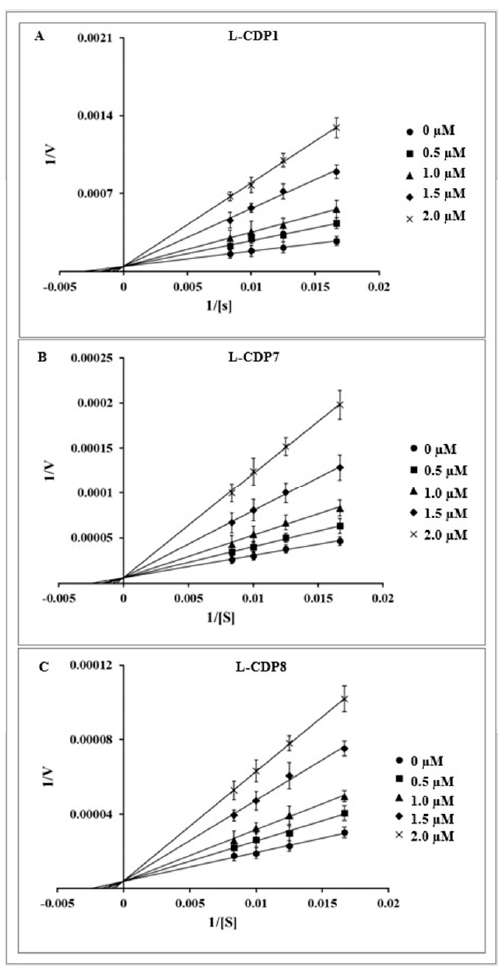
Figure 3. Inhibition mode of L-CDP1, L-CDP7, and L-CDP8 over SARS-CoV-2 3CL pro . Lineweaver- Burk plots to determine the inhibition modes are presented. [S] is the substrate concentration; v is the initial reaction rate. ( A ): Lineweaver-Burk plot for L-CDP1 inhibition of SARS-CoV-2 3CL pro . ( B ): Lineweaver-Burk plot for L-CDP7 inhibition of SARS-CoV-2 3CL pro . ( C ): Lineweaver-Burk plot for L-CDP8 inhibition of SARS-CoV-2 3CL pro . Data shown are the mean ± SD from 3 independent measurements ( n = 3).